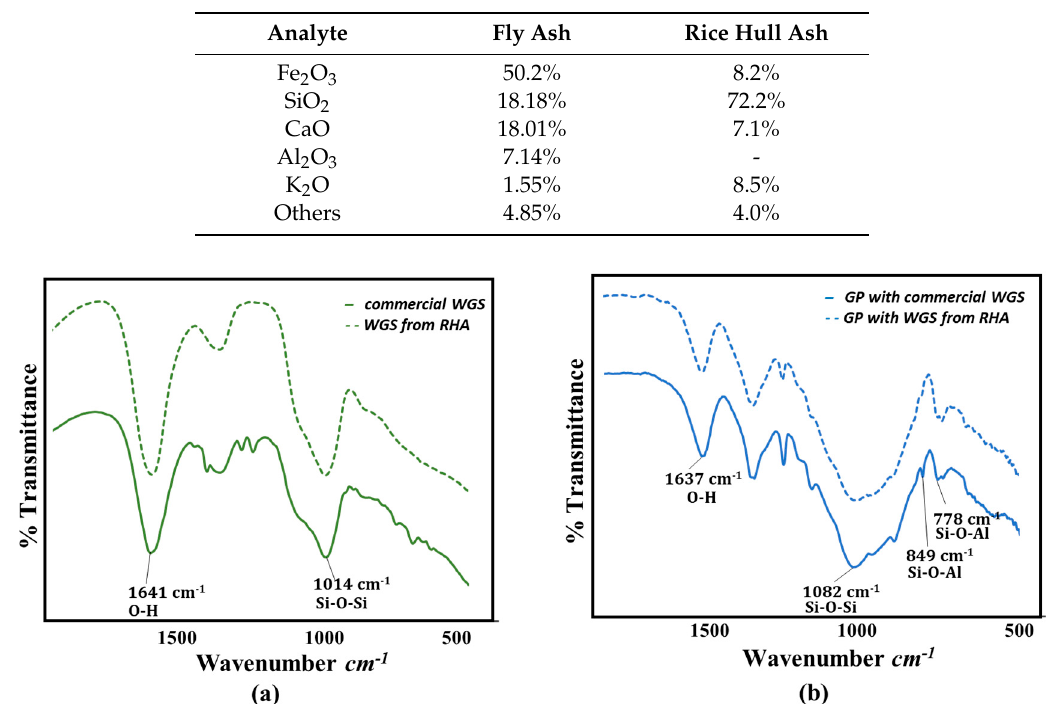
Figure 2. Infrared profile of ( a ) water glass solution (WGS) and ( b ) geopolymer (GP) sphere prepared using ( ̶ ) commercial and (--) extracted WGS.